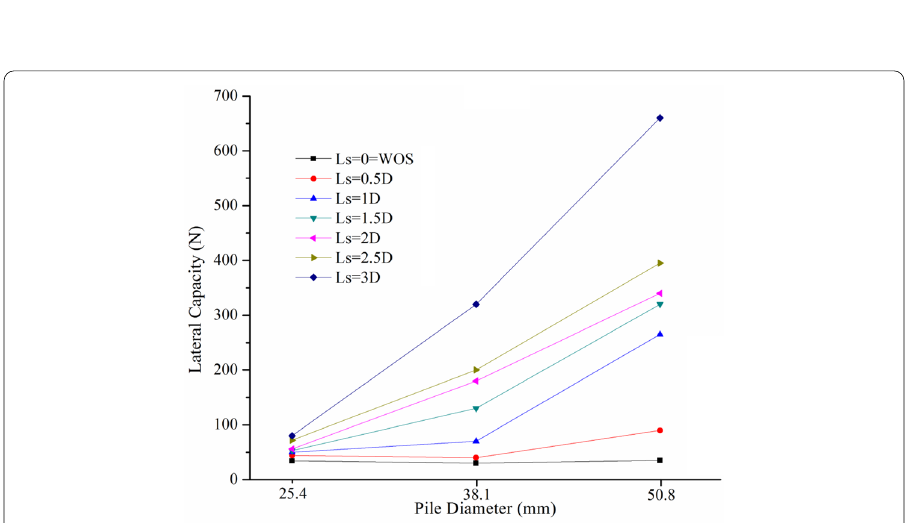
Fig. 11 Lateral capacity of pile with varying depth of socketing for pile having embedded depth L e 400